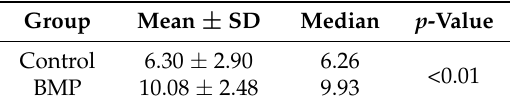
Table 1. New bone volume within the area of interest ( n = 16; mm 3 ).